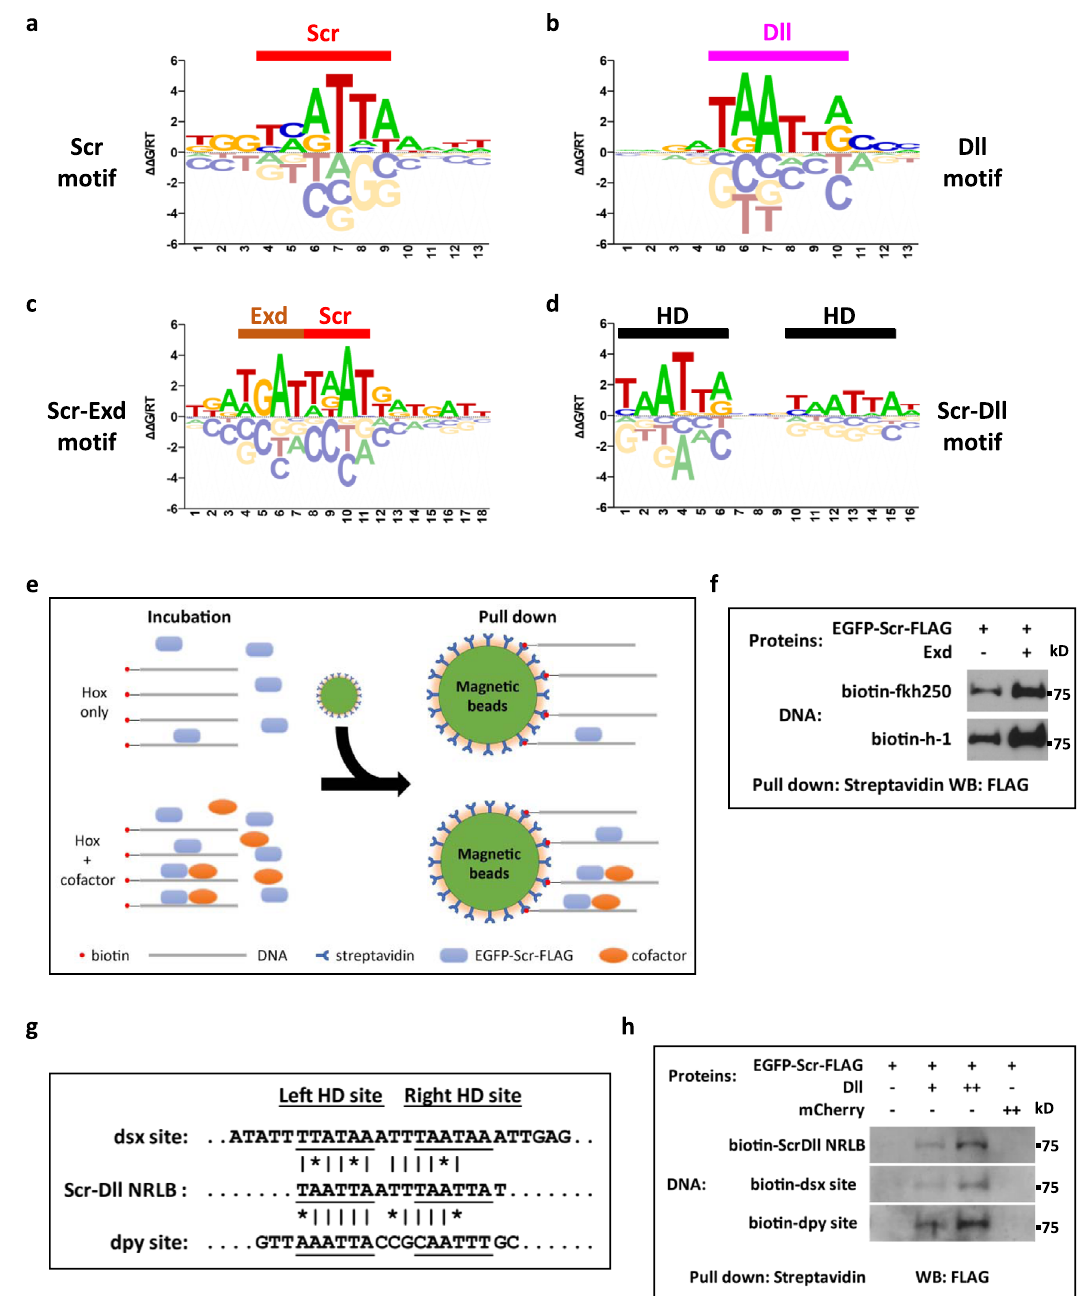
monomer model. c Scr-Exd dimer model. d Scr-Dll dimer model. Half-sites are indicated in Scr-Exd ( c ) and Scr-Dll ( d ) dimer models. e Schematic